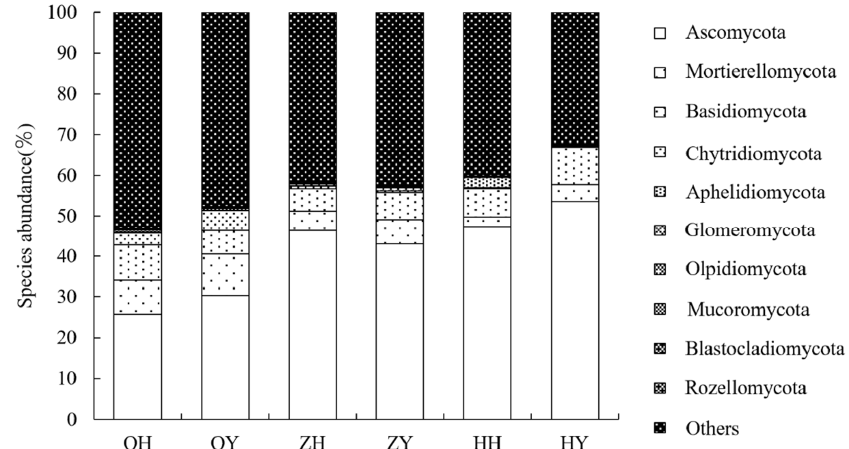
Figure 6. Relative abundance of fungal communities in rhizosphere soil treated with carbon-based fertilizer and chemical fertilizers. Note: QH-Chemical fertilizer treatment on 8 July; QY-Carbon- based fertilizer treatment on 8 July; ZH-Chemical fertilizer treatment on 16 August; ZY-Carbon- based fertilizer treatment on 16 August; HH-Chemical fertilizer treatment on 26 September; HY- Carbon-based fertilizer treatment on 26 September.